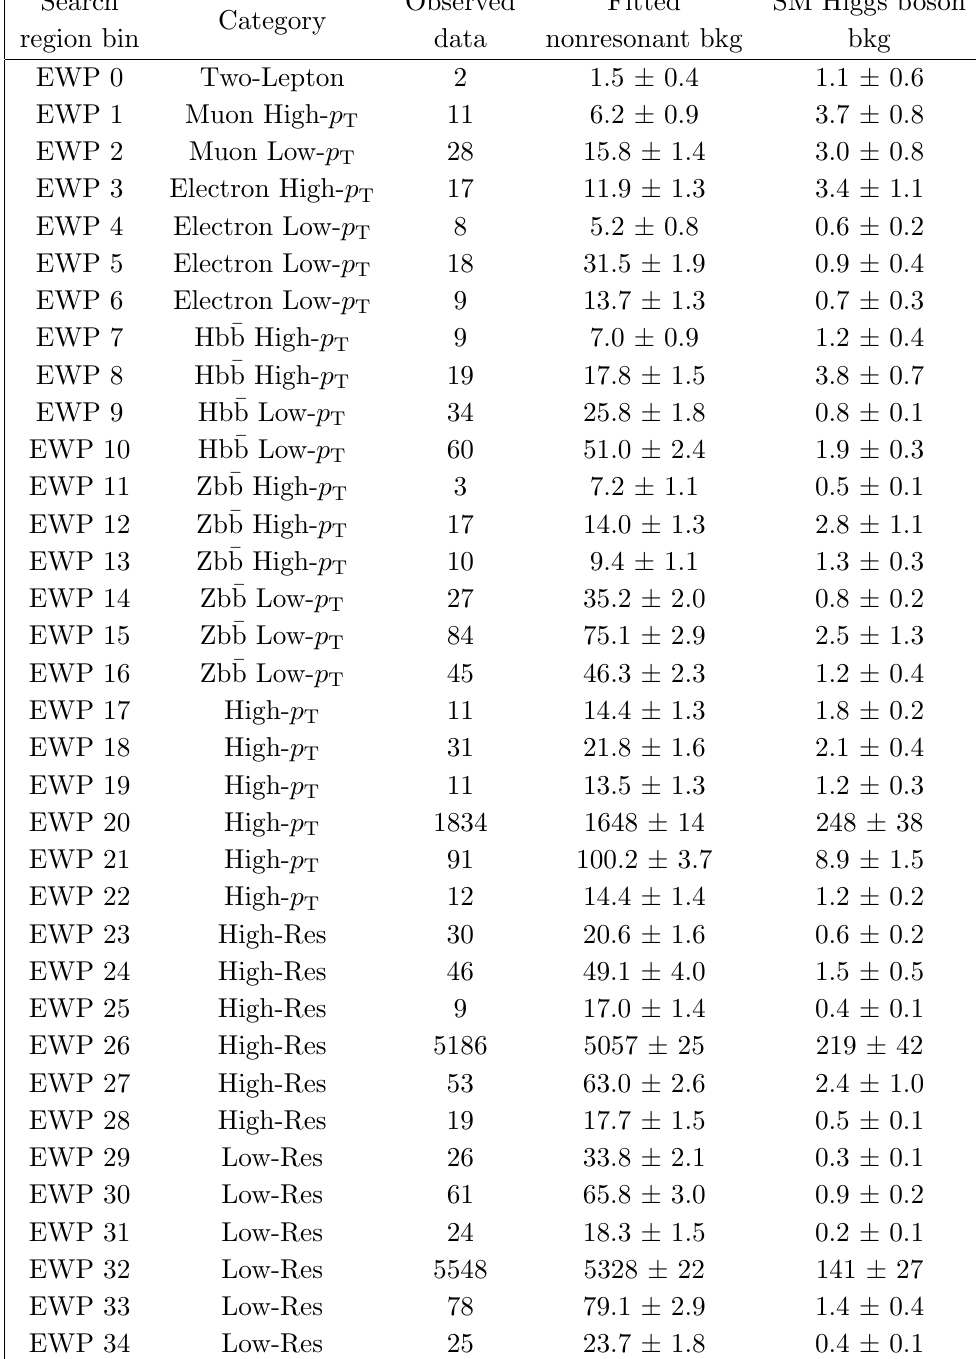
Table 7 . The observed data, (cid:12)tted nonresonant background yields, and SM Higgs boson back- ground yields within the mass window between 122 and 129 GeV are shown for each search region bin of the EWP analysis. The uncertainties quoted are the (cid:12)t uncertainties, which include the impact of all systematic